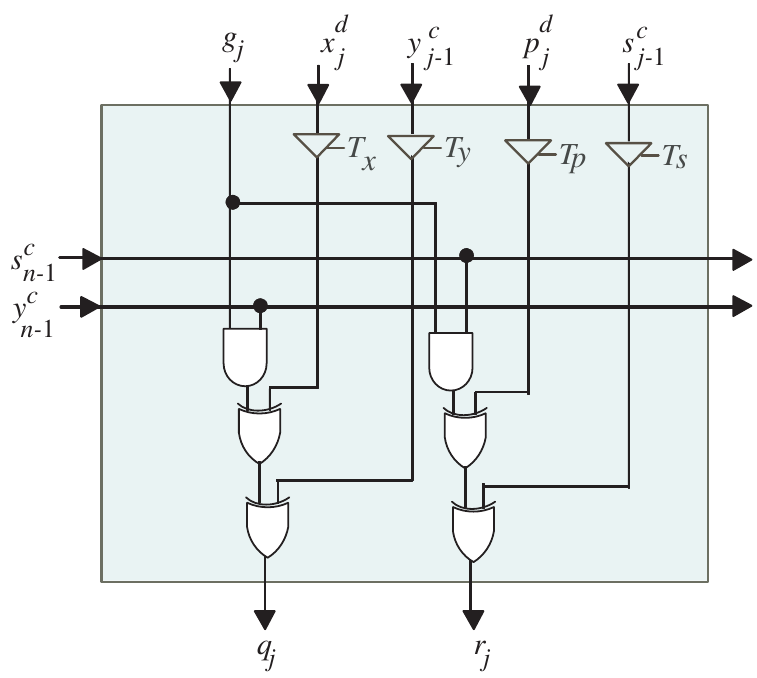
Figure 9. Logic details of the light blue